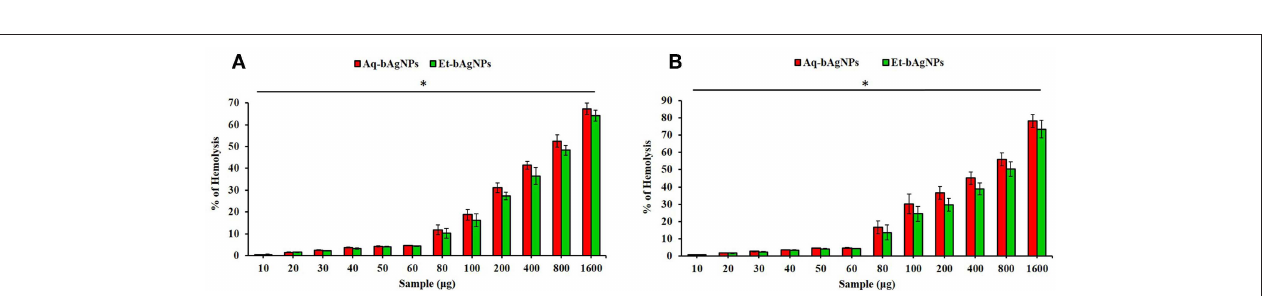
FIGURE 6 | Hemocompatibility of bAgNPs to human (A) and rat (B) red blood cells (RBCs). The HC 50 values of Aq-bAgNPs and Et-bAgNPs to human RBCs were 700 and 800 µ g, respectively. However, the HC 50 values of Aq-bAgNPs and Et-bAgNPs to rat RBCs were 600 and 800 µ g, respectively. The hemocompatibility assay was performed three times on three different days. The values presented are mean ± SE of multiple samples ( n = 3) and paired t- test was performed for analyzing significant difference between Aq-bAgNPs and Et-bAgNPs. The hemocompatibility of bAgNPs was significantly different from each other and * P ≤